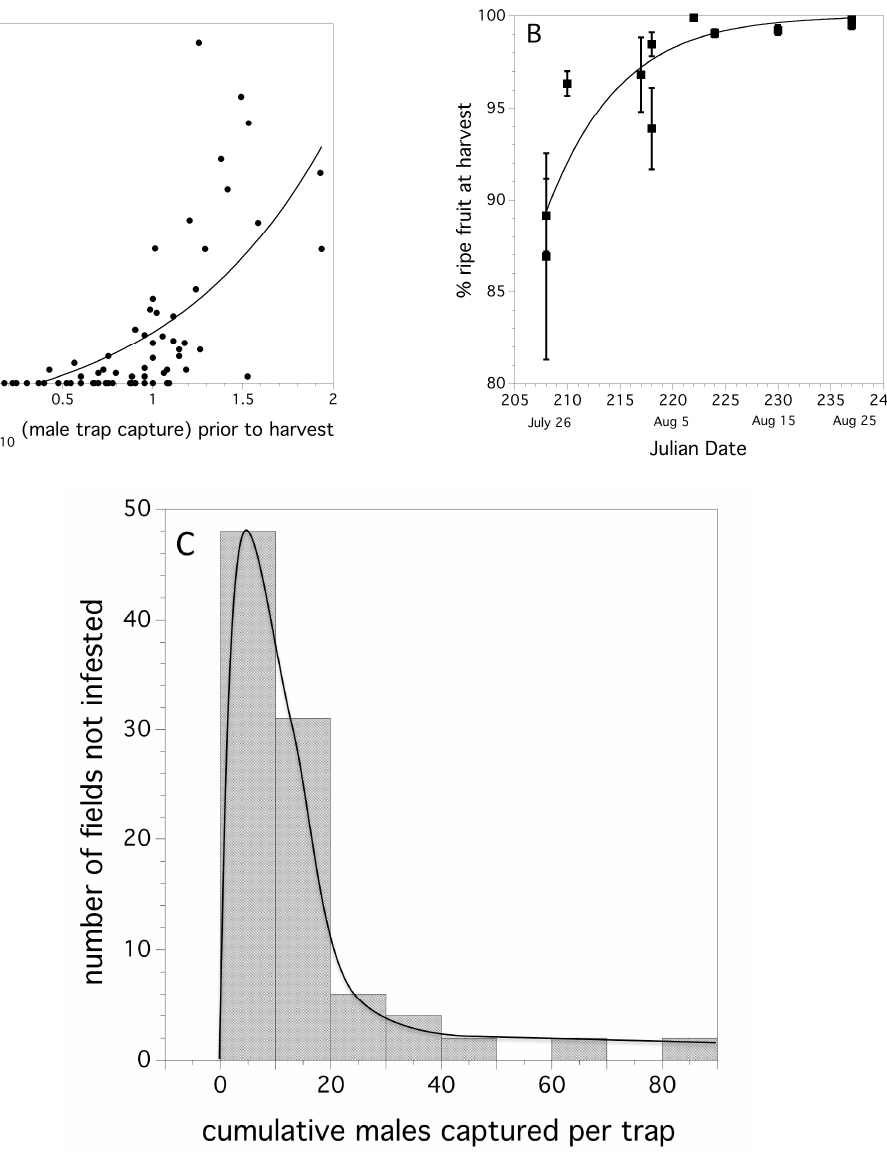
Figure 9. Exponential relationship between percent infested wild blueberry fruit and cumulative male D. suzukii trap capture (logarithmic transformed) prior to harvest ( A ), percentage ripe fruit as the harvest season progresses (2016), error bars are standard errors ( B ), histogram for all 92 wild blueberry fields that prior or at harvest were not infested (2012–2017), based on the mean number of cumulative male trap captures in the week before the harvest. The Gamma distribution that is fitted to the data with maximum likelihood methods is also shown in this graph ( C ).